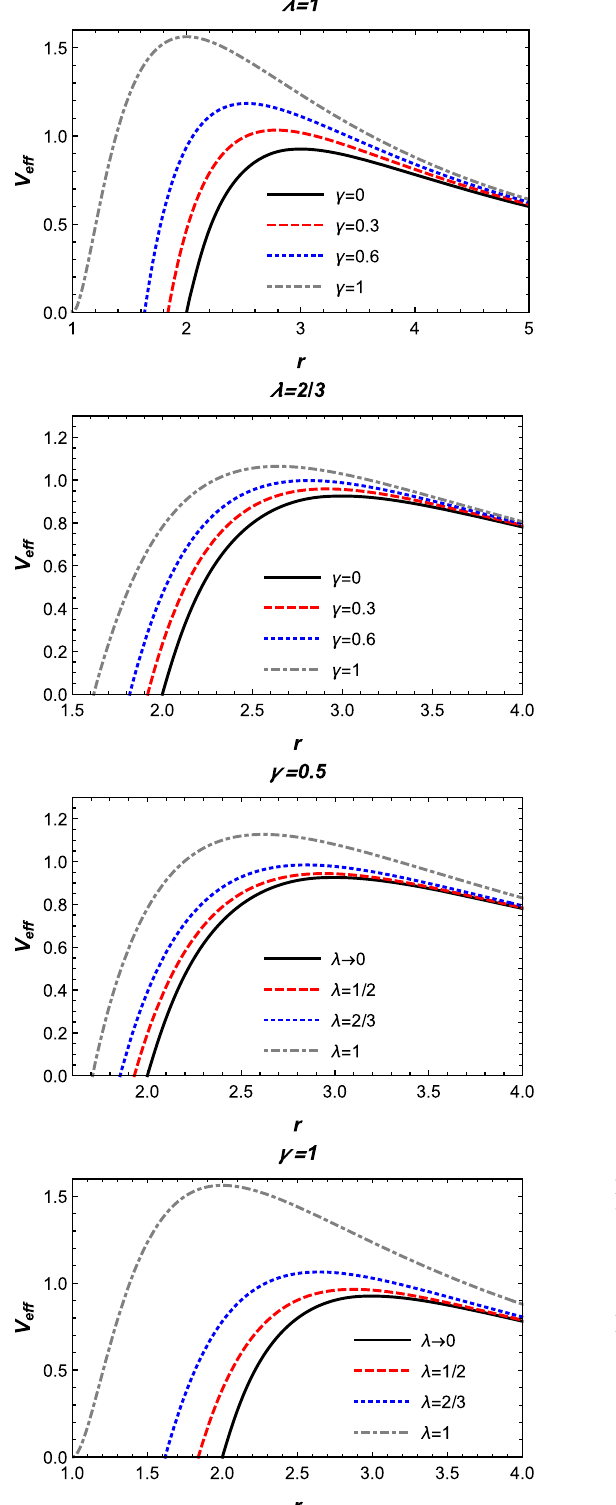
Fig. 6 The dependence of effective potential V ef f on radial coordi- nates for different values of λ and γ for the photon ( m = 0)